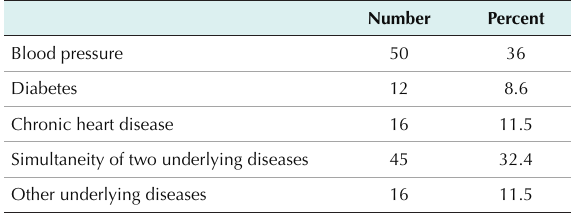
Table 1 . Distribution of Underlying